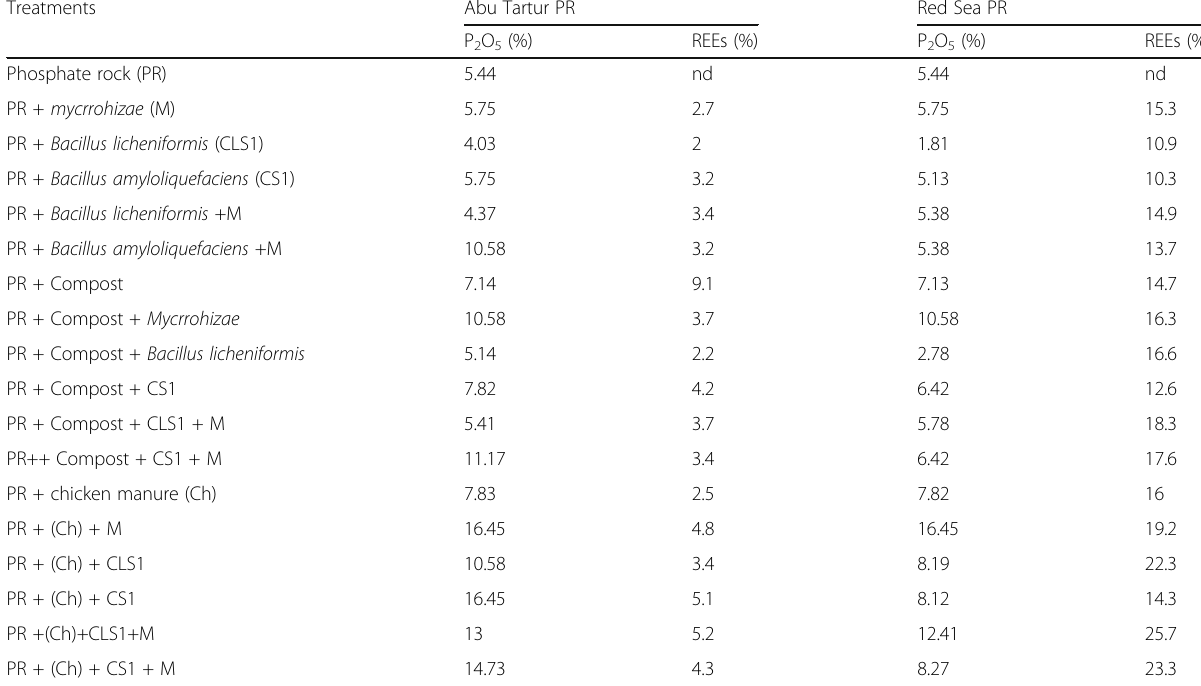
Table 3 Residual of P 2 O 5 and REEs in clay soil after harvesting of wheat Treatments Abu Tartur PR Red Sea PR P 2 O 5 (%) Phosphate rock (PR)